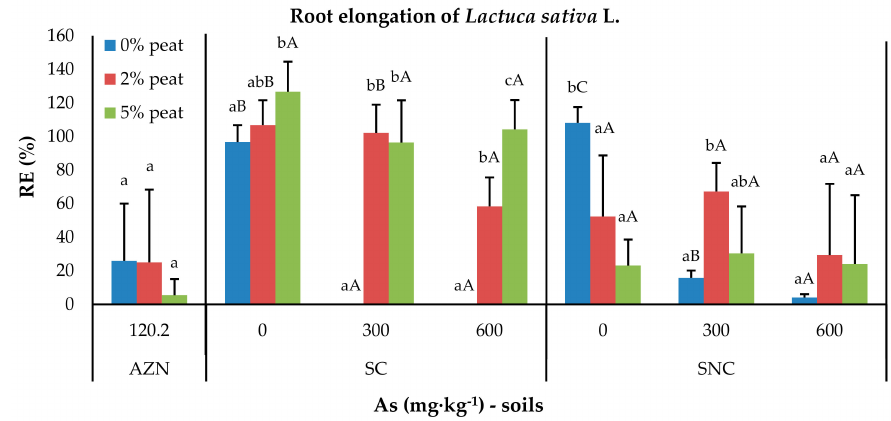
Figure 3. Lactuca sativa L. root elongation (RE%) in the soils with di ff erent treatments. Lowercase letters indicate statistically significant di ff erences for each treatment with di ff erent peat additions; and capital letters among the di ff erent treatments with As for the same peat content (Kruskal-Wallis test, p < 0.05). Values higher than 100% indicate hormesis.